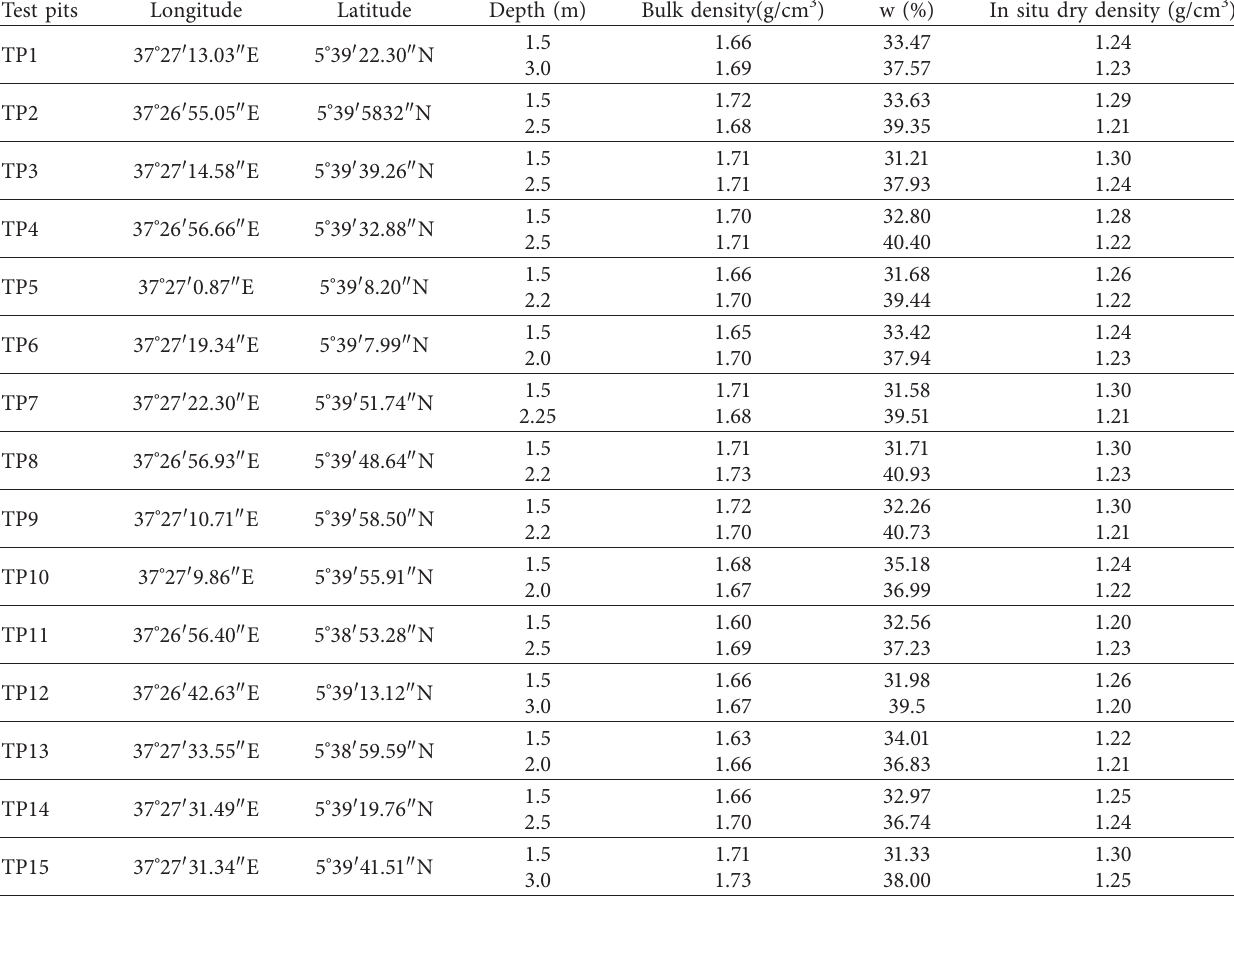
Table 1: Test pit locations and in situ test results.